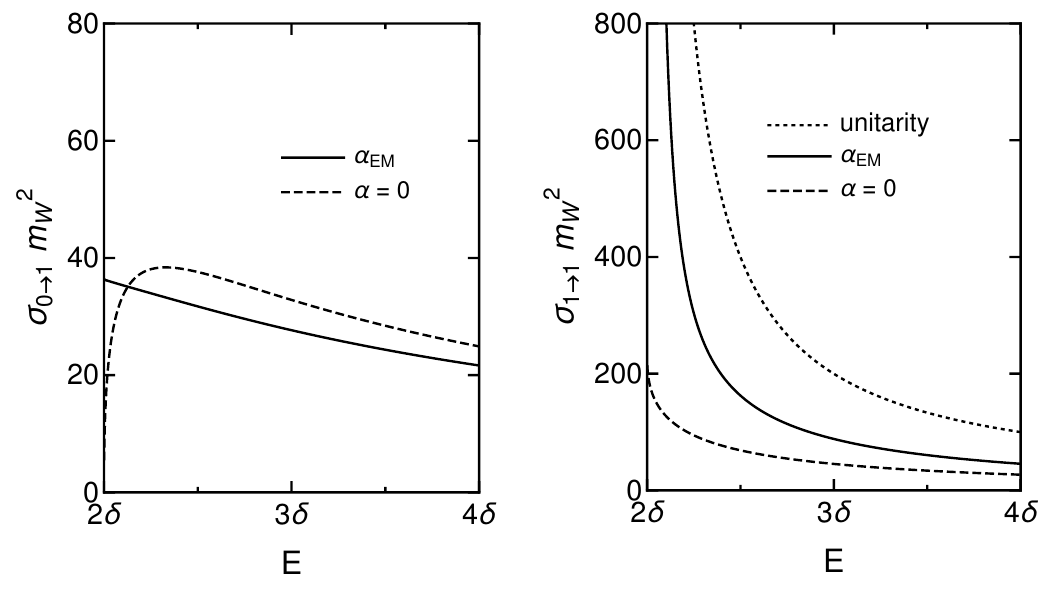
Figure 5 . The neutral-to-charged transition cross section (cid:27) 0 ! 1 (left panel) and the charged- wino elastic cross section (cid:27) 1 ! 1 (right panel) as functions of the energy E . The cross sections for M = 2 : 39 TeV are shown for (cid:11) = 1 = 137 (solid curves) and for (cid:11) = 0 (dashed curves). In the right panel, the dotted curve is the S-wave unitarity bound in eq.